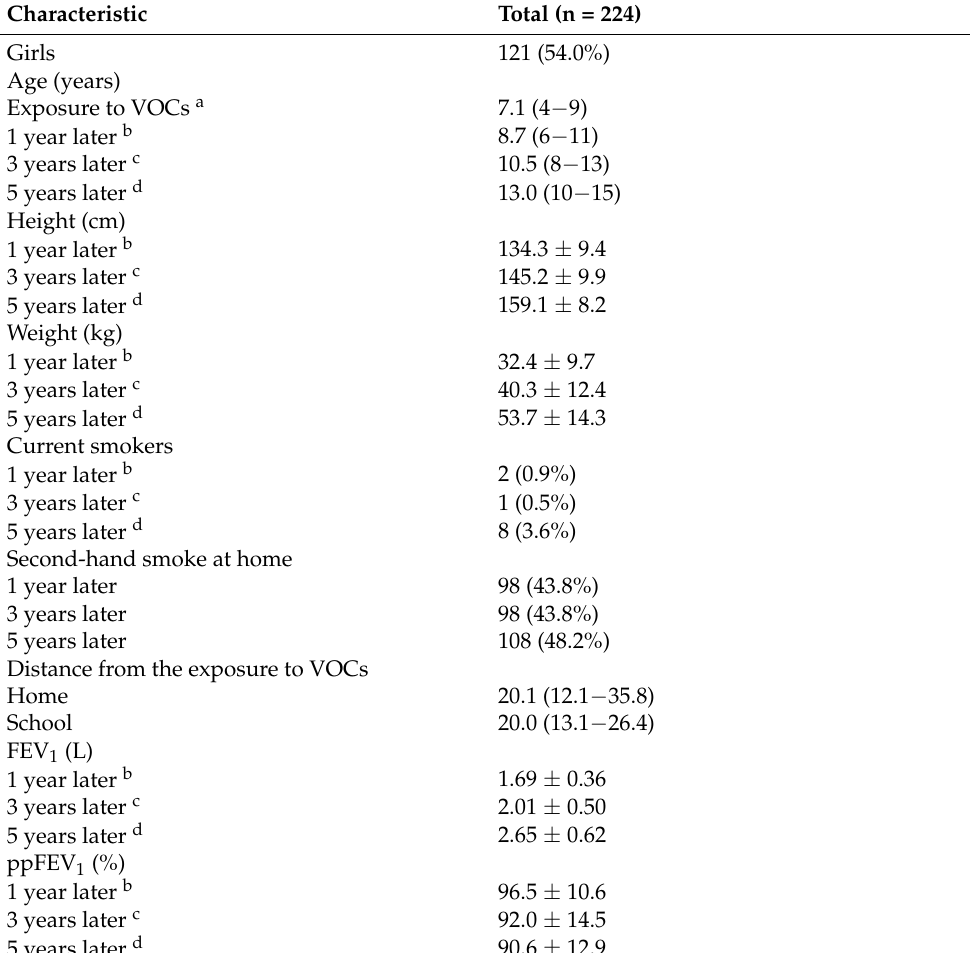
Table 1. Characteristics of the participants including lung